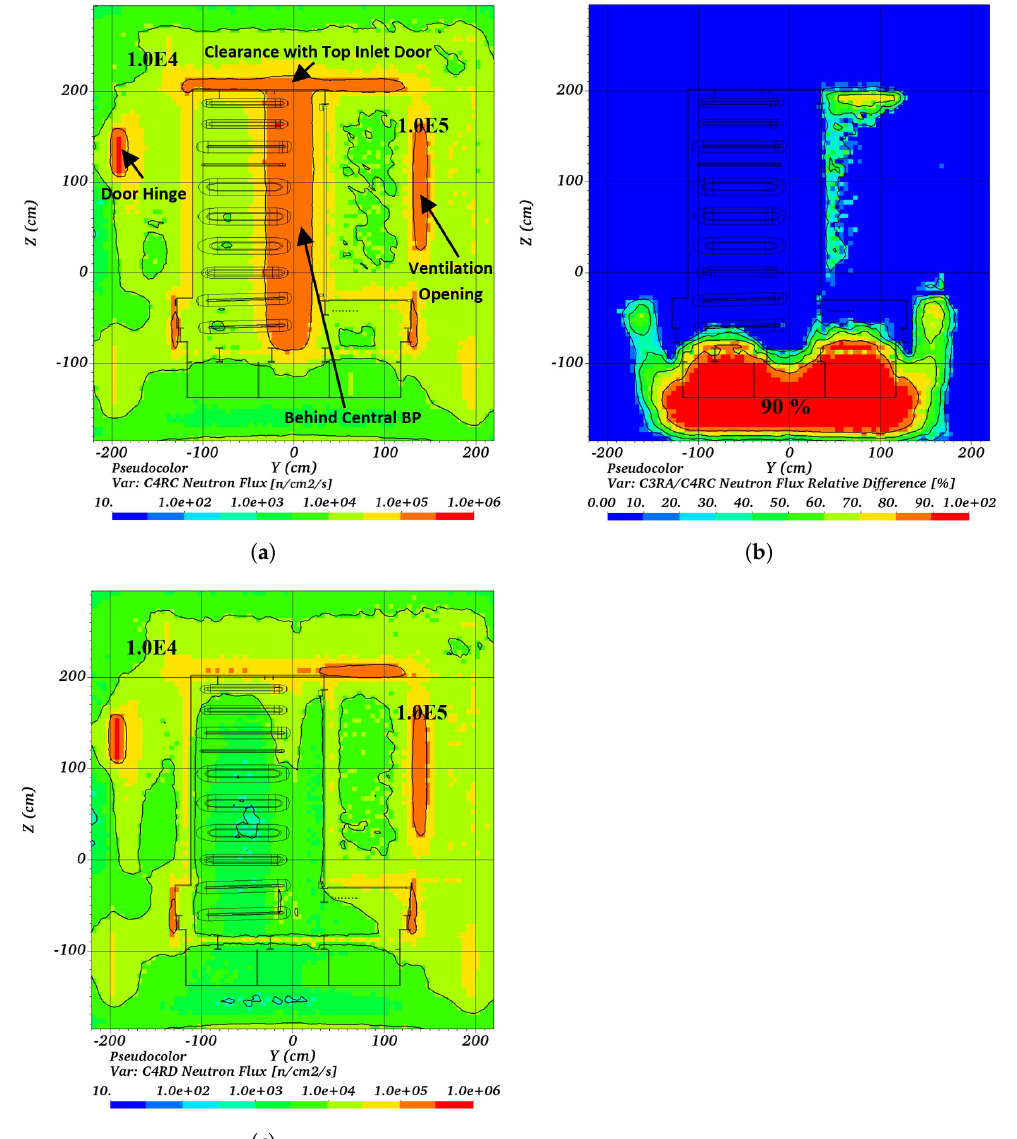
Figure 8. ( a ) C4RC total neutron flux [n/cm 2 /s] behind the BP, ( b ) relative decrease in comparison